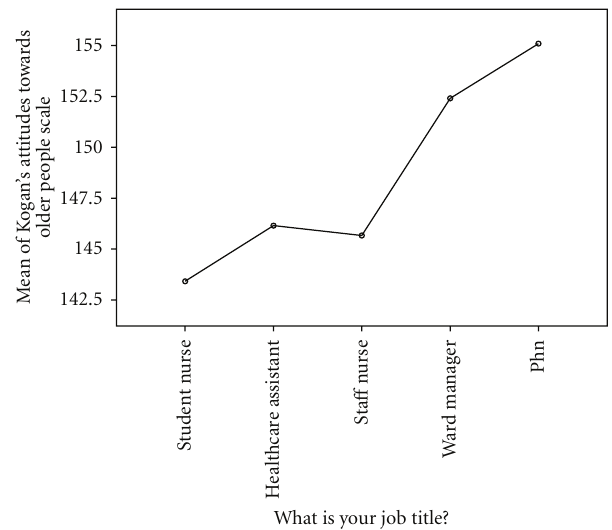
Figure 1: Kogan’s attitudes towards old people scale scores by